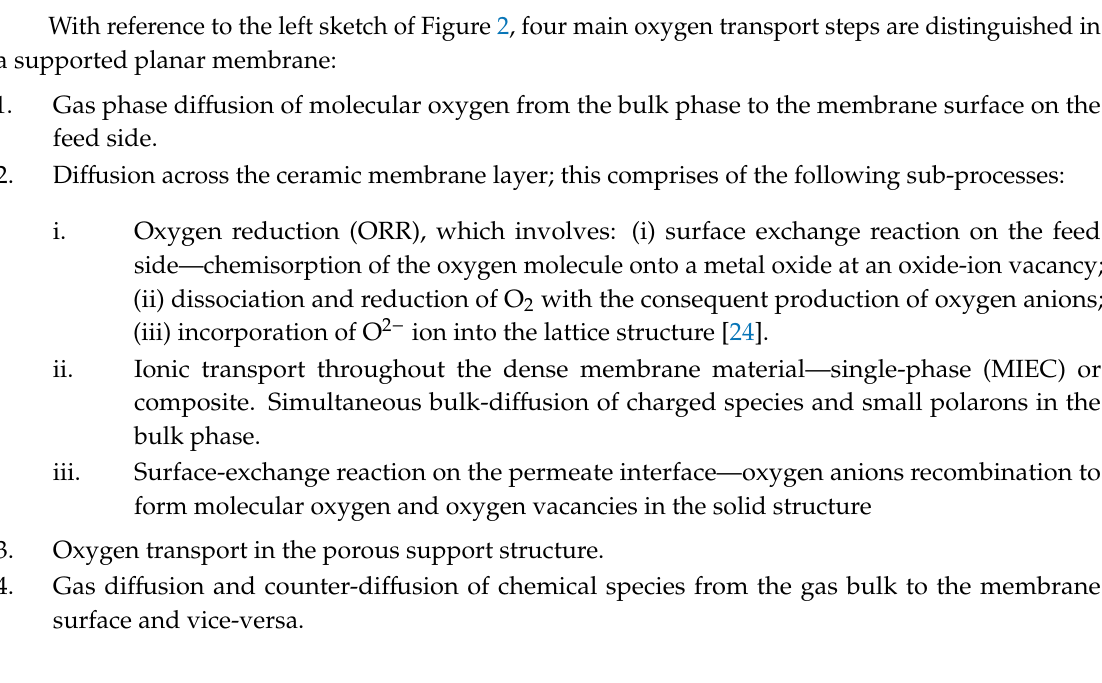
Figure 2. Schematic representation of the membrane module ( a ) and the associated O 2 partial pressure qualitative profile ( b ).